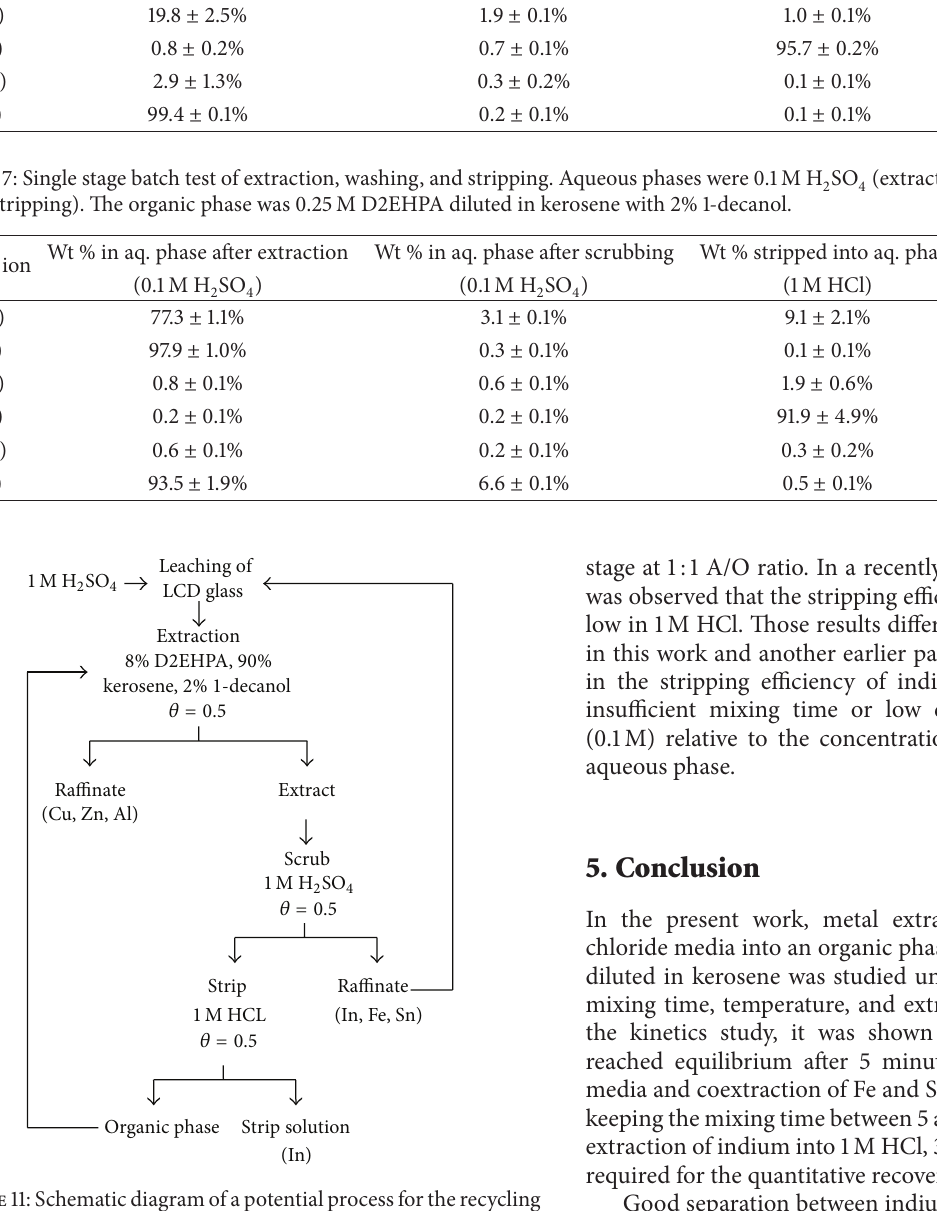
Table 6: Single stage batch test of extraction, washing, and stripping. Aqueous phases were 1M H HCl (stripping). The organic phase was 0.25 M D2EHPA diluted in kerosene with 2% 1-decanol. Wt % in aq. phase after extraction Metal ion